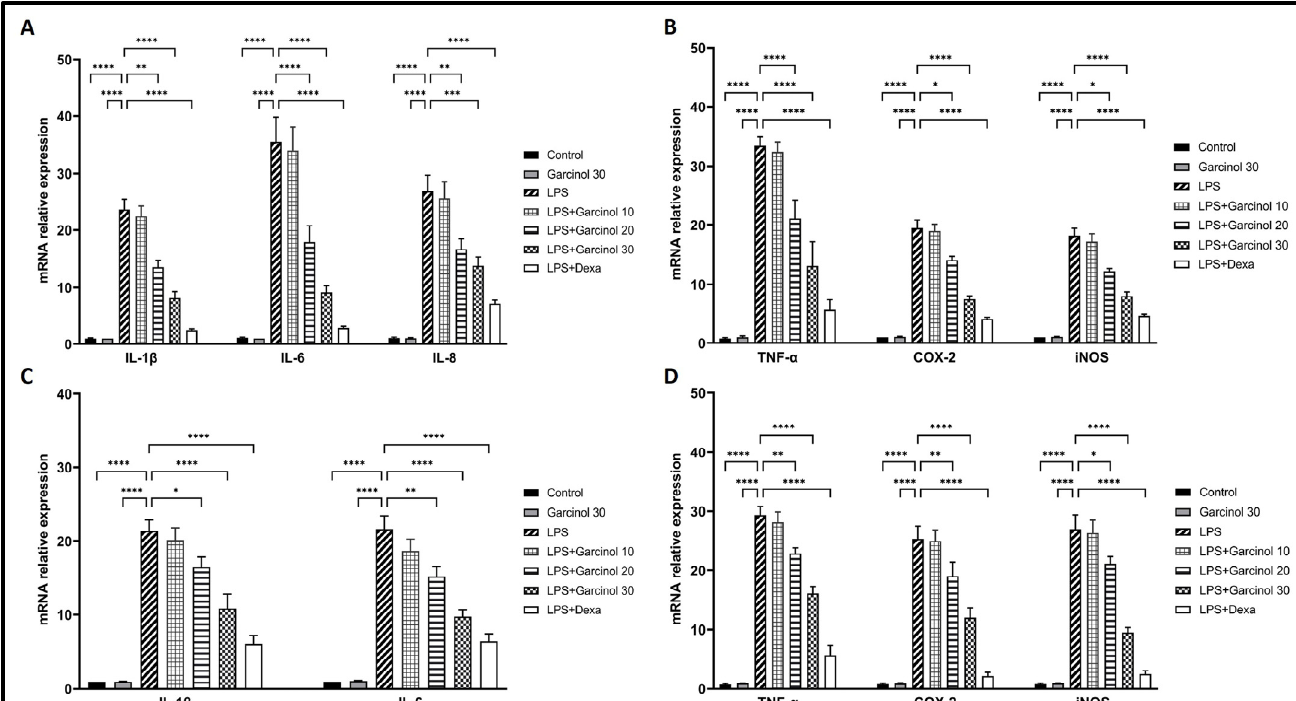
Figure 3. Effects of garcinol (10, 20, and 30 µ M) on the mRNA expression level of a pro-inflammatory- related molecule, including TNF- α , COX-2, iNOS, IL-8, IL-6, and IL -1 β in THP-1 cells ( A , B ) and RAW 264.7 cells ( C , D ) activated with LPS 500 ng/mL. 5 µ M of dexamethasone (dexa) was used as a positive control. The gene expression was determined by using qRT-PCR. For normalization, the GAPDH gene was used. The results of qRT-PCR of mentioned molecules are presented as a relative fold change of the control. The data are presented in three independent experiments as the mean ± SD of triplicate examination. For statistical analyses, One-way ANOVA and Dunne tt (cid:31)s test were used. * p < 0.05, ** p < 0.01, *** p < 0.001, **** p < 0.0001.